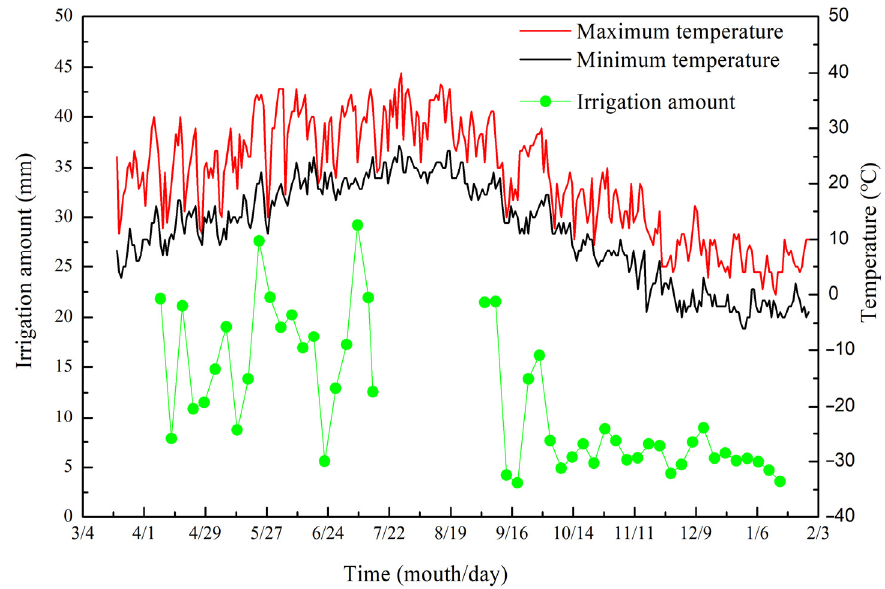
Figure 1. Irrigation date, amount and greenhouse temperature during the growing season.